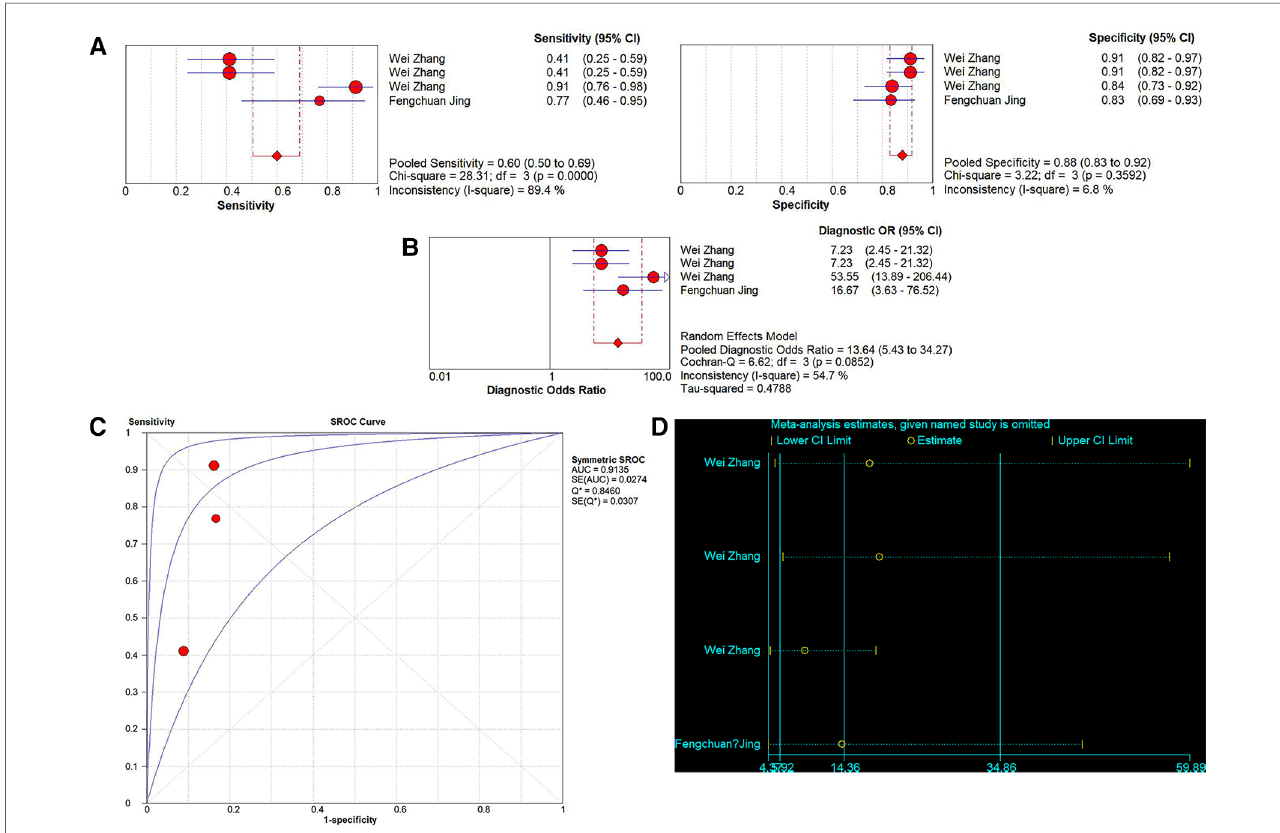
FIGURE 6 Pooled results of the studies on ncRNAs differentiating IVIG-resistant KD patients from IVIG-responsive KD patients among 4 studies. ( A ) Pooled sensitivity and speci fi city; ( B ) Pooled DOR; ( C ) SROC. ( D ) Sensitivity analysis of the results of the meta-analysis for IVIG-resistant KD patients from IVIG-responsive KD